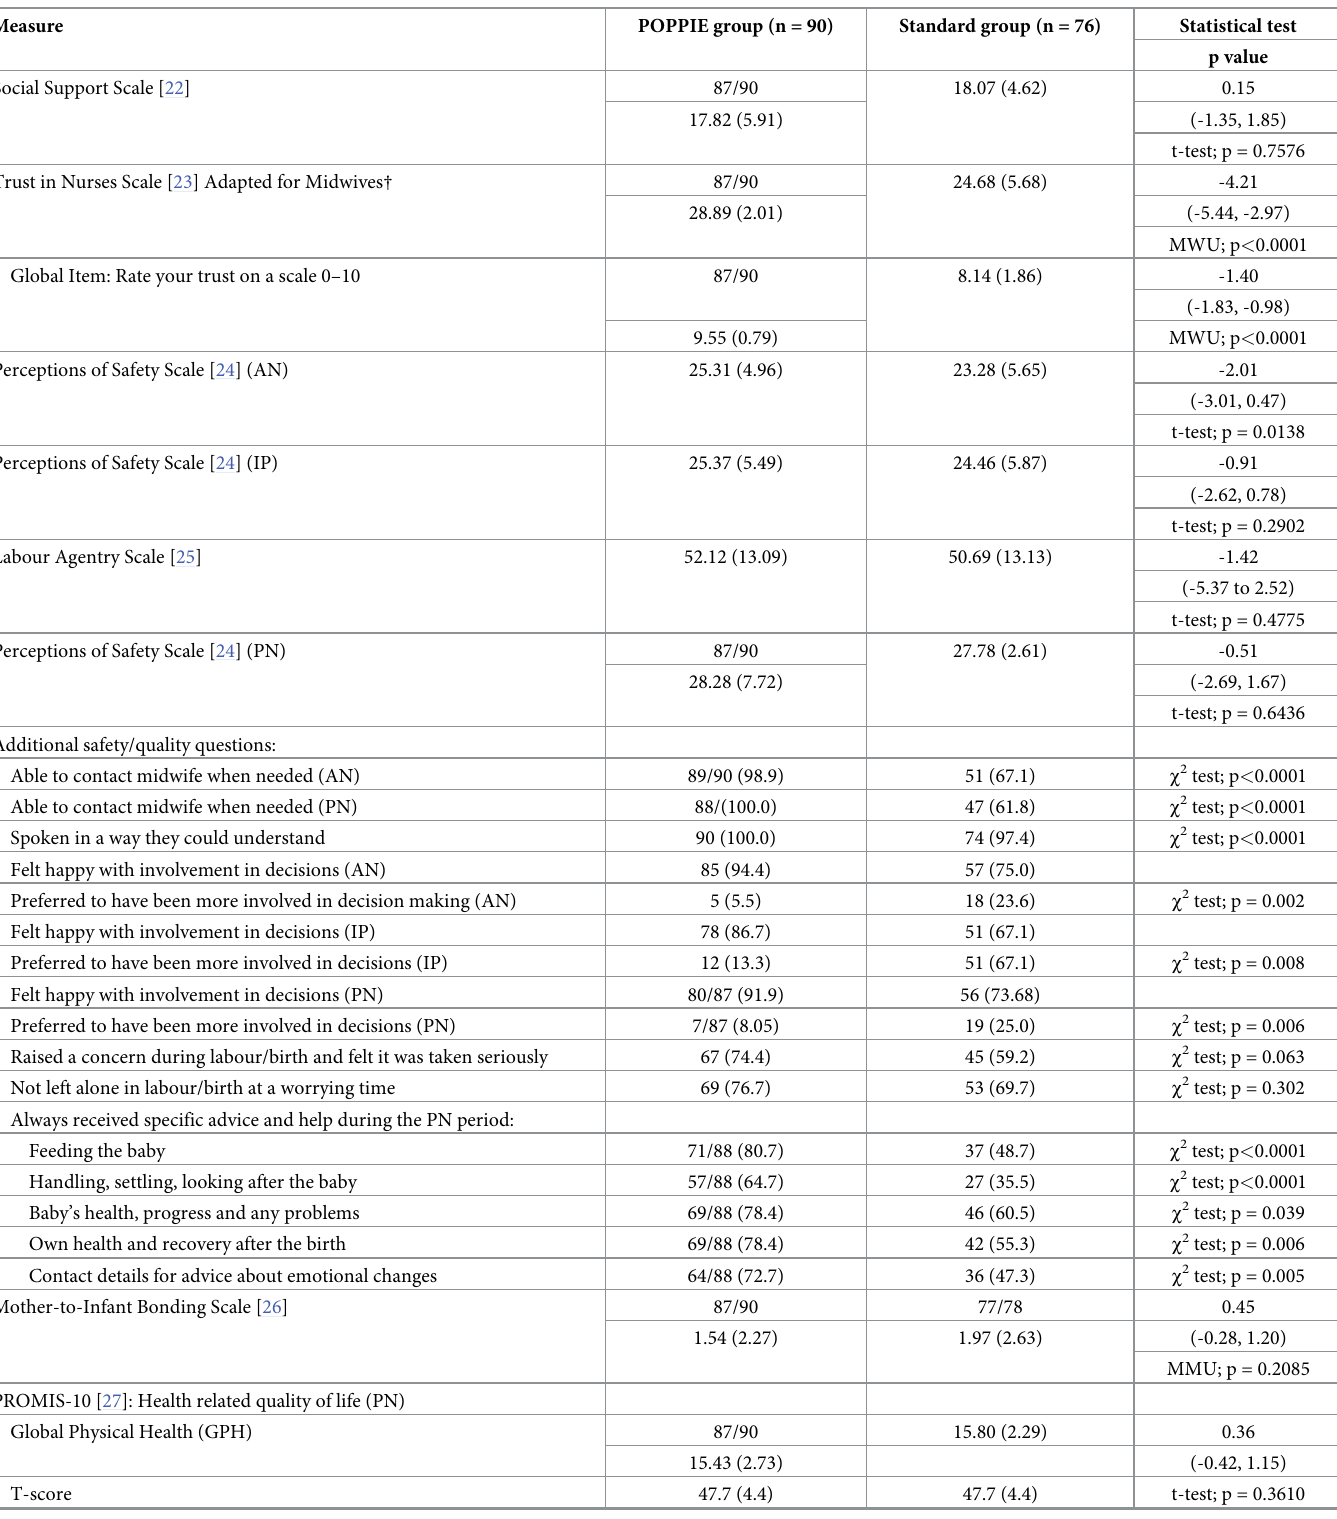
Table 2. Overview of survey quantitative